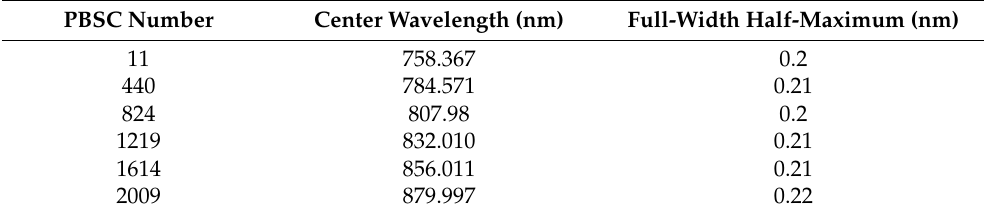
Table 7. Spectral calibration results of water vapor absorption band with observation channel (channel